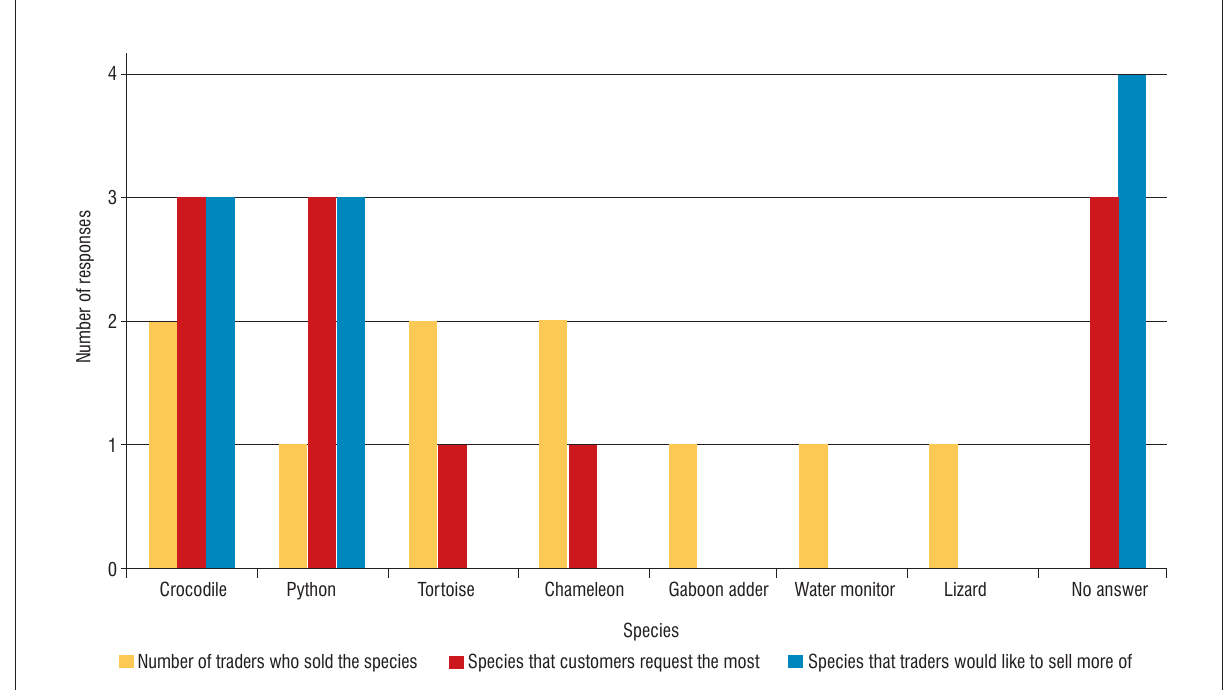
Figure 2: Variation in the number of traders selling reptile species, and the customers’ and traders’ preferences for medicinal reptiles. (Xipamanine Survey 1, March 2015. A comparative study in January 2016 was not